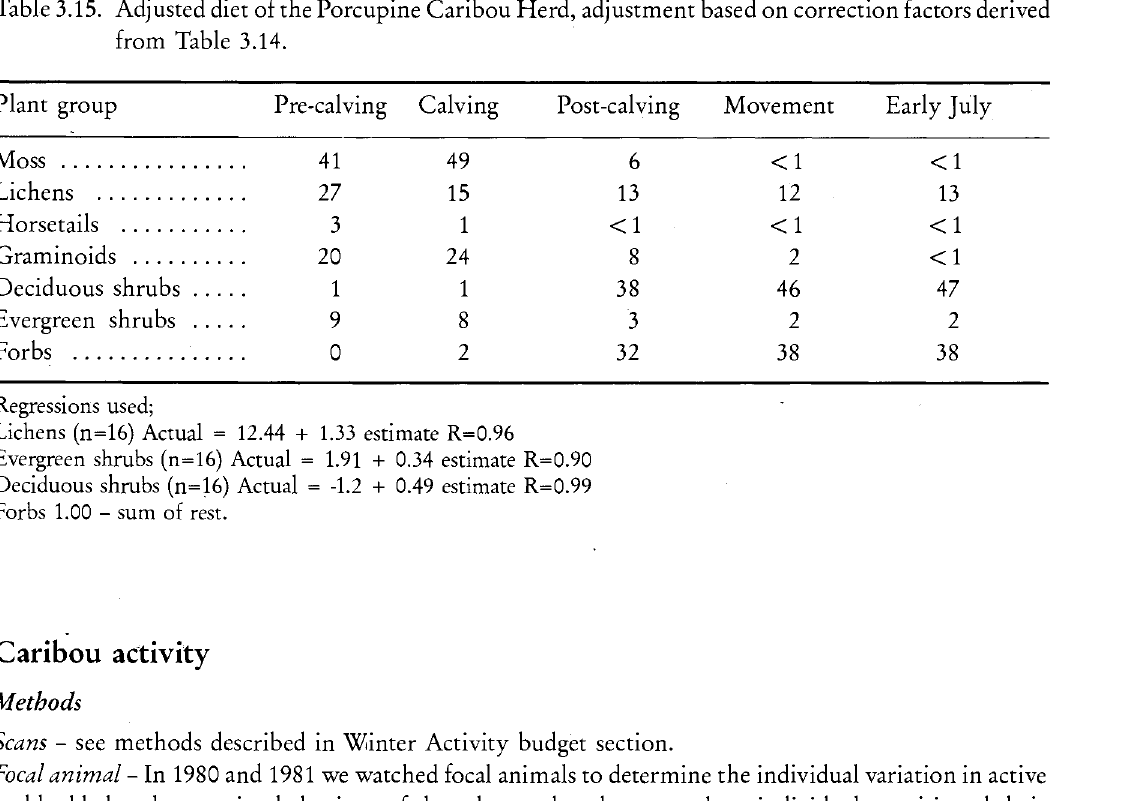
Table 3.15. Adjusted diet of the Porcupine Caribou Herd, adjustment based on correction factors derived from Table